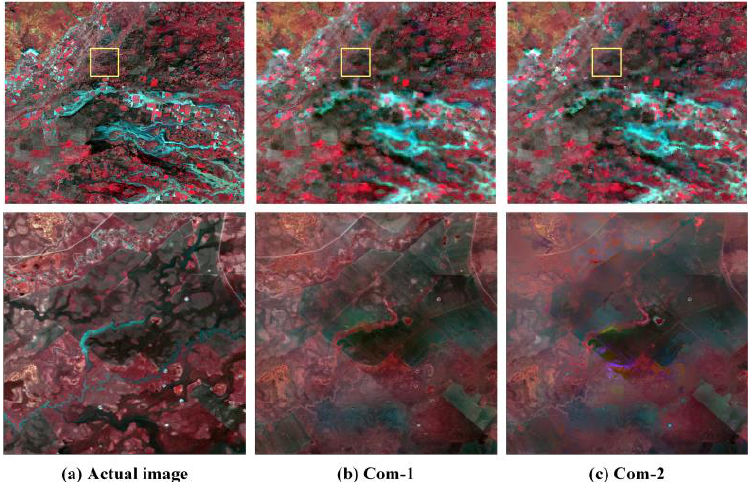
Figure 15. Comparison of the visual effects of the sliding window-combination (Com-1) and CLS- combination (Com-2) methods applied to the LGC site. ( a ) Actual image. ( b ) Com-1. ( c ) Com-2.